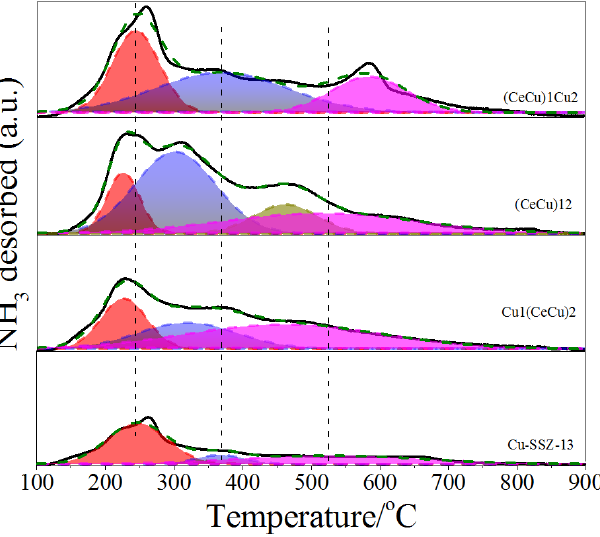
Figure 6. NH 3 -TPD profiles of Cu-SSZ-13 and Ce-modified Cu-SSZ-13 catalysts. 3. Materials and